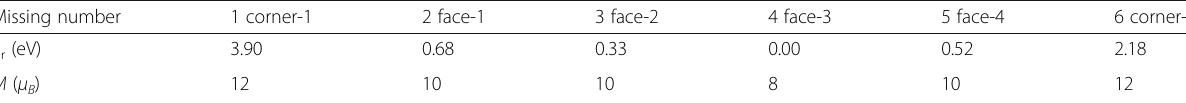
Table 2 The relative energies E r (eV) and total magnetic moments M ( μ B ) of optimized configurations with a BN-pair missing at specific positions